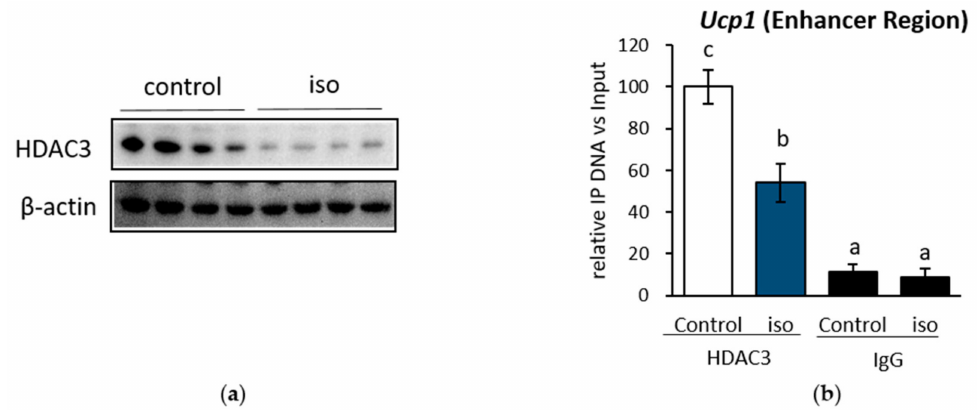
Figure 5. HDAC3 protein level was decreased under β -AR stimulation in IWAT cell. ( a ) HDAC3 protein level, and its recruitment level in ( b ) the Ucp1 enhancer region after treatment with 10 µ M iso for 4 h. Data are presented as mean ± S.E.M. (error bars). n = 4–6 in each group. β -actin act as loading control and IgG as a mock control. Different letters indicate significant differences ( p < 0.05) according to one-way ANOVA followed by the Tukey-Kramer multiple comparison test. Same letters indicate non-significant